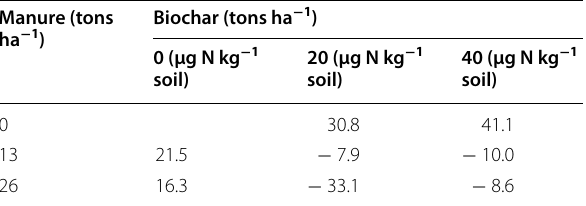
0.05. Vertical bars = 3). M0, M13 and M26 are =